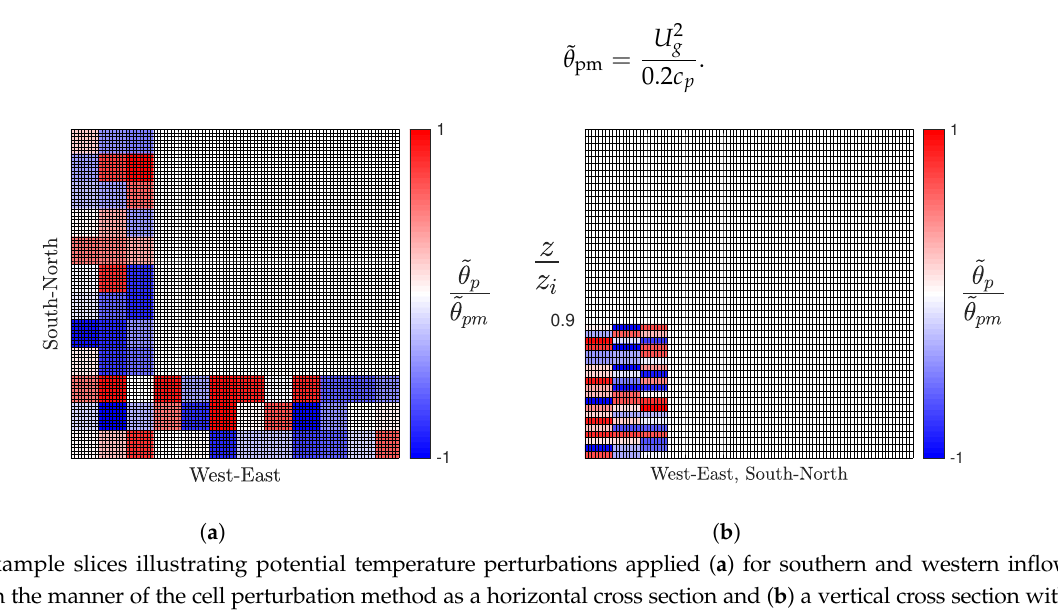
Figure 1. Example slices illustrating potential temperature perturbations applied ( a ) for southern and western inflow boundaries in the manner of the cell perturbation method as a horizontal cross section and ( b ) a vertical cross section with inflow from the left boundary. The potential temperature perturbation, θ p , is drawn from a uniform distribution centered at zero with θ pm as the maximum possible magnitude, applied from the first vertical level to a height of 0.9 times the boundary layer height, and using the same perturbation for a 8 × 8 grid point ‘cell’ with 3 such cells, 24 grid points, along each lateral